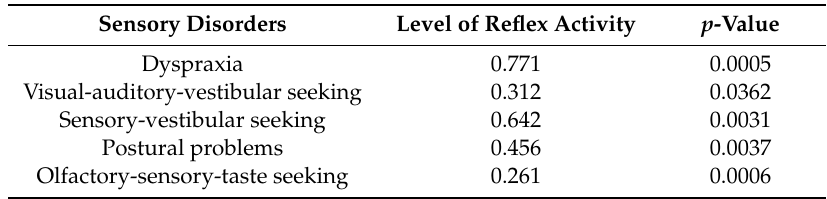
Table 4. Coe ffi cient of determination (R-squared) of sensory disorders with the corresponding activity level of